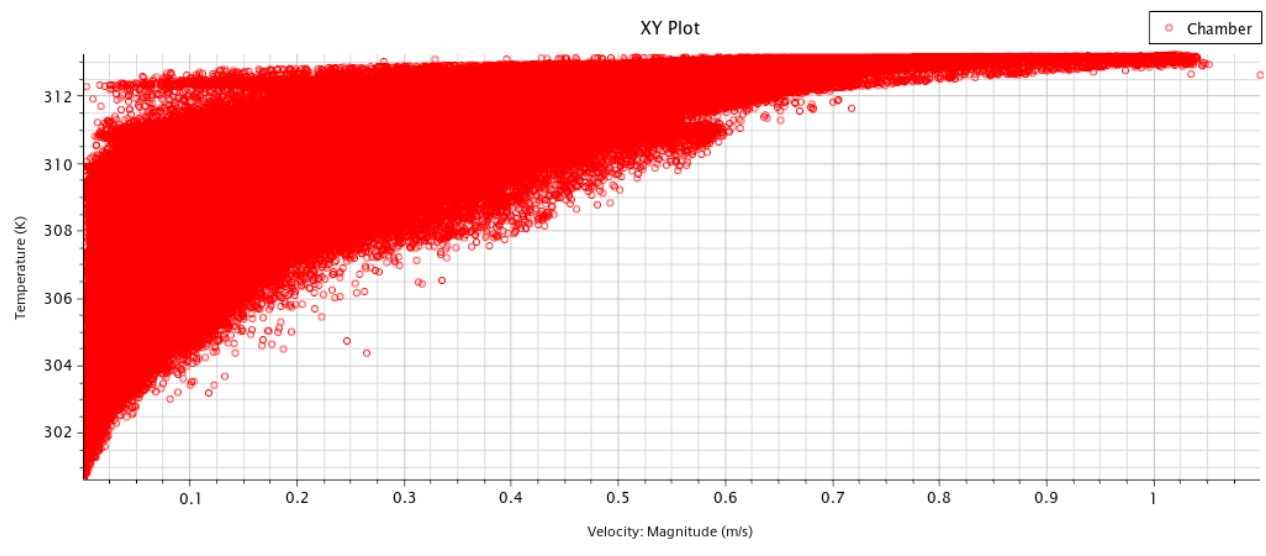
Figure 8. Velocity vs. temperature in the drying chamber.